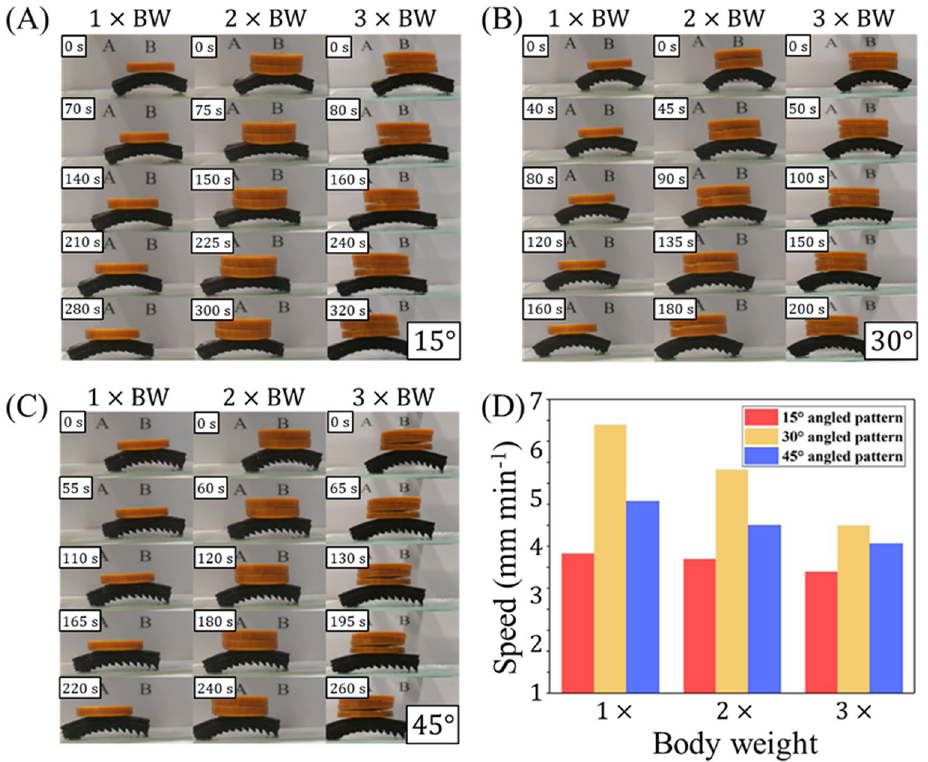
Figure 9. Load motion experiment of mag-bot with different angled pattern. (A–C) Mag-bots with (A) 15°, (B) 30°, and (C) 45° are displayed, each undergoing one cycle of loading (chronologically from top-to-bottom) while carrying loads that are (left) 1 × , (center) 2 × , and (right) 3 × their body weight. (D) Travel speeds of mag-bots with different pattern angles of (red) 15°, (yellow) 30°, and (blue) 45° under loads of (left) 1 × , (center) 2 × , and (right) 3 × a mag-bot’s body weight are displayed.